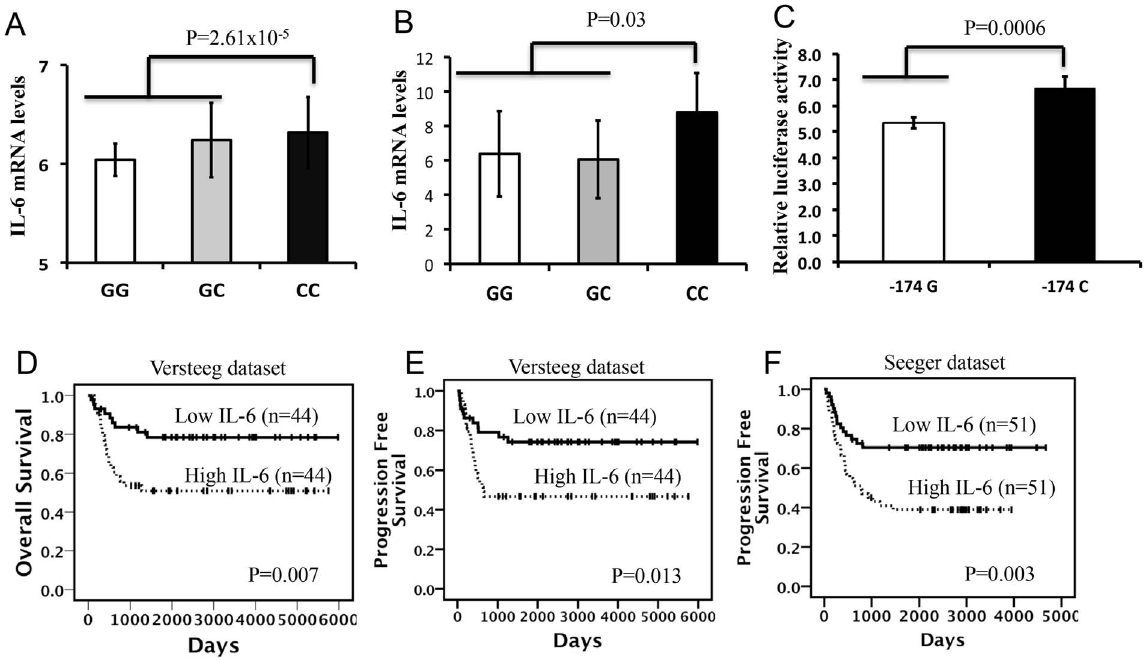
Figure 2. SNP genotype correlation to IL-6 gene expression and NB outcome. In silico and qRT-PCR analysis of IL-6 mRNA expression in (A) 198 LCLs and (B) 31 NB tumors, respectively, stratified according to the SNP IL-6 –174. (C) Luciferase report gene assay carried out in HEK293 cells. Data shown in percentage are the mean 6 SD from three independent transfection experiments, each done in triplicate and compared with promoter less control. Kaplan-Meier analysis is shown, with individuals grouped by median of expression of IL-6 for OS and Progression Free Survival (PFS) rates in (D and E) 88 NB patients and (F) only PFS for 102 INSS stage 4 patients with MYCN not amplified. OS data of Seeger dataset were not available.